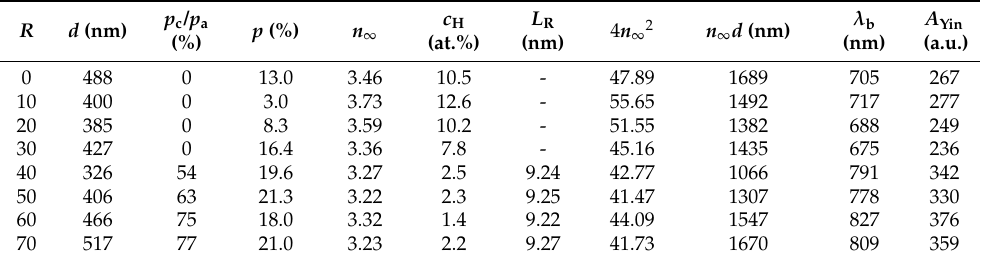
Table 1. Sample characterization: d thickness by UV Vis, p c p a crystalline/amorphous phase volume fraction ratio, p porosity, n ∞ refractive index in the long-wavelength limit, all from [19], c H hydrogen concentration according to FTIR, L R crystallite size according to Raman scattering, λ b benchmark wavelength, A Yint integrated direct Yablonovitch